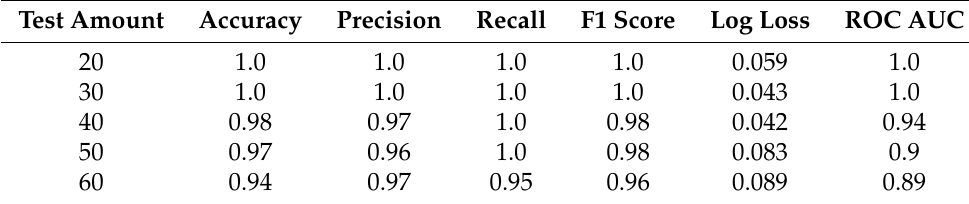
Table 10. Data exfiltration RF test data amounts.